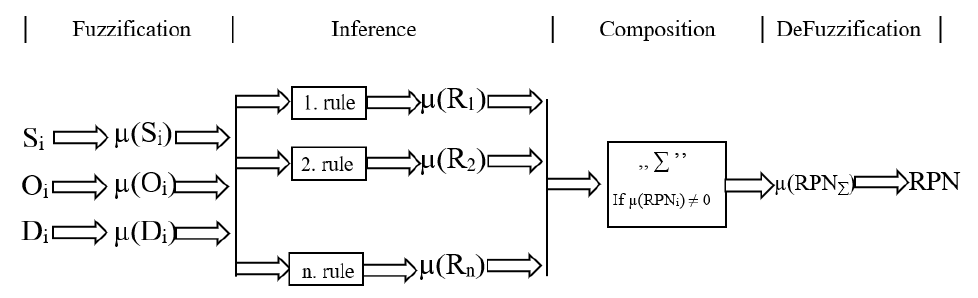
Figure 2. Flow chart of the fuzzy logic process for FMEA.